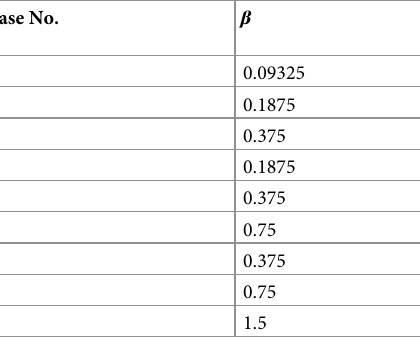
Fig 3. a. Cumulative new infected of quicker recovery in different stages. b. Cumulative new infected of lower transmission in different stages. c. Cumulative new infected of quicker recovery and lower transmission in different stages.